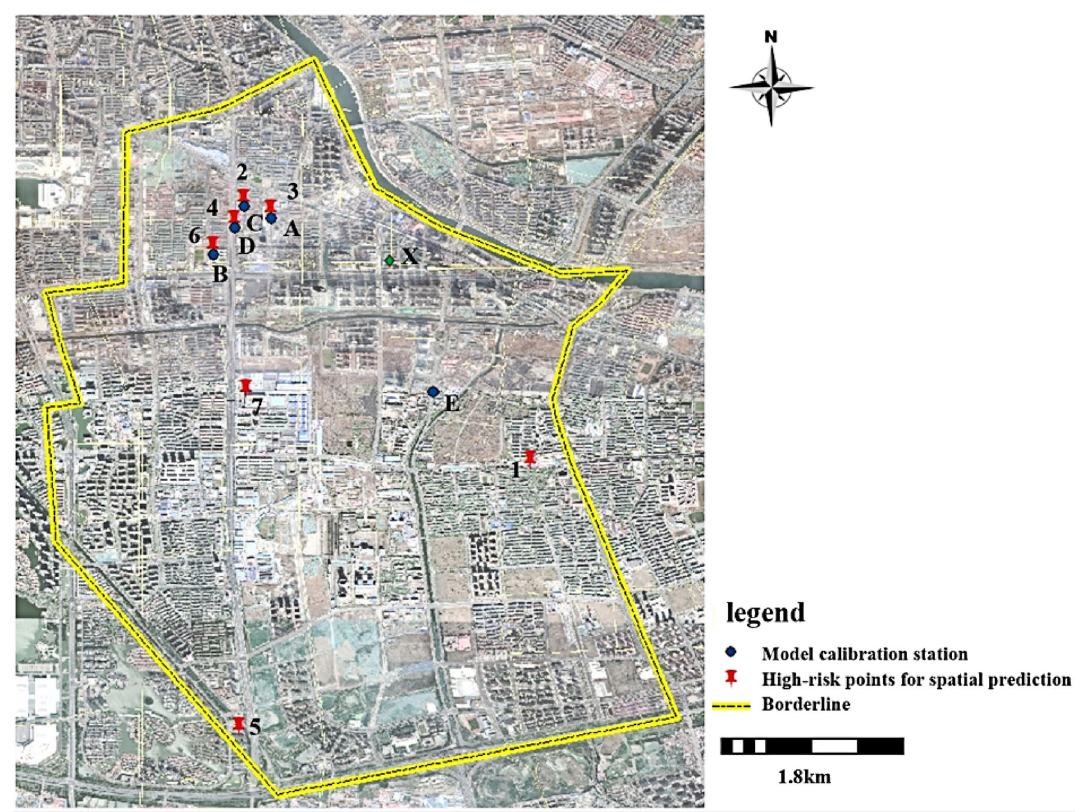
Fig. 7 Spatial location of the water depth prediction points in the study area on Jiefang South Road in Tianjin Municipality, China. X refers to Xiufangli rainfall station in Tianjin Municipality, China. Table 2 Coordinates of the seven high-risk points in the drainage area on Jiefang South Road in Tianjin Municipality, China High-risk point X